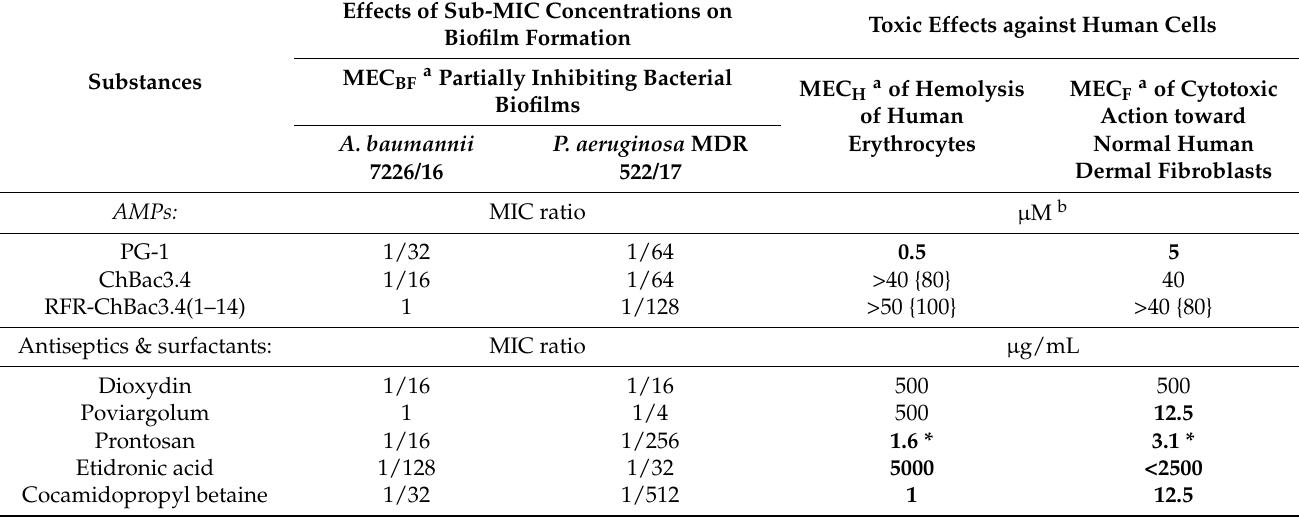
Table 3. Individual effects of AMPs, antiseptics, and surfactants against forming biofilms and eukaryotic cells (human erythrocytes and human dermal